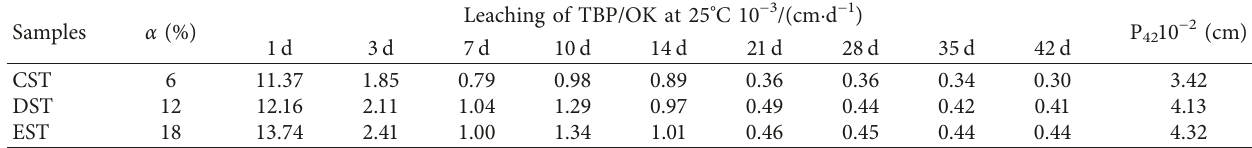
Table 1: Leaching rates of TBP/OK in PAG-solidified TBP/OK samples (SPT). Samples